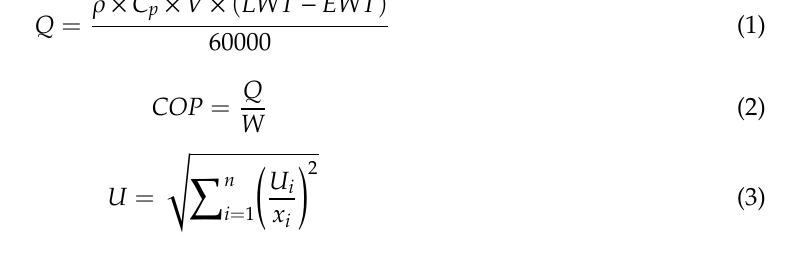
Table 1. Test conditions.